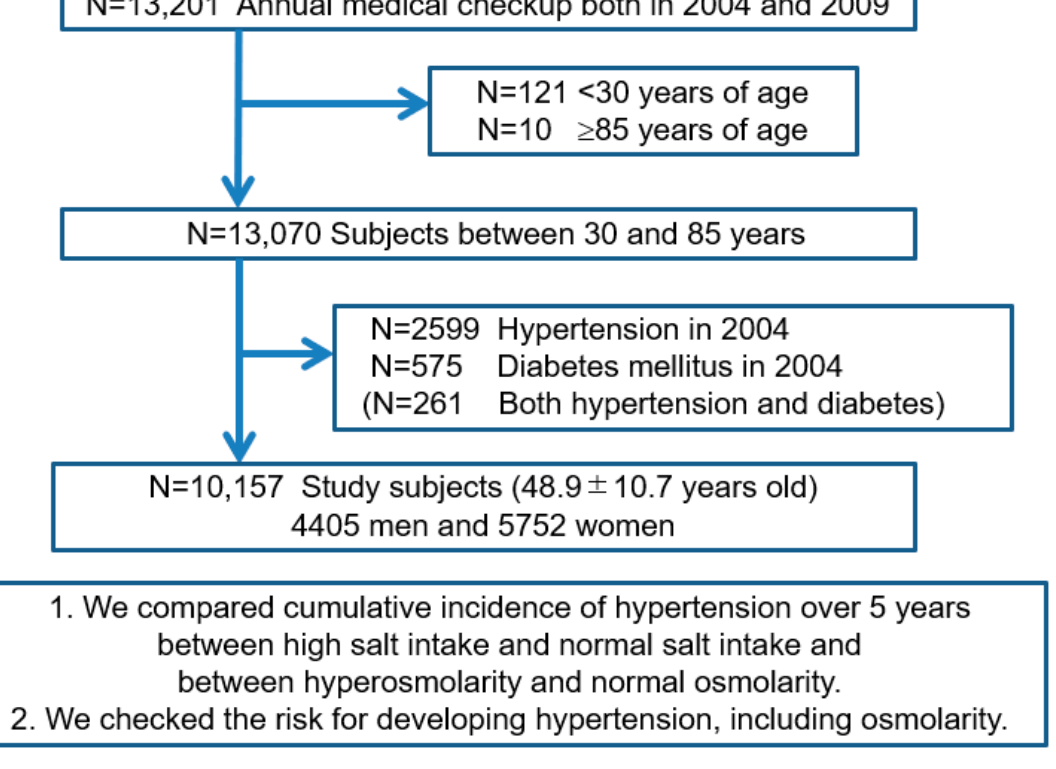
Table 1. Baseline demographic data on the study subjects and the difference of baseline data between the developing hypertension (HT) group and non-hypertension (non-HT) group.